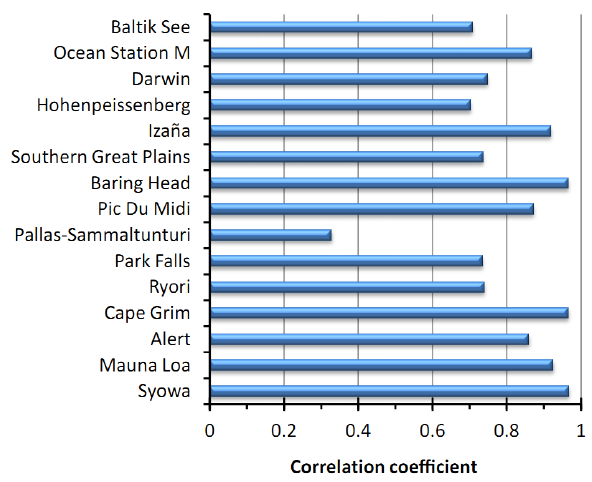
Fig. 7. Correlation coefficients between simulated and observed CH 4 at GLOBALVIEW stations . 975